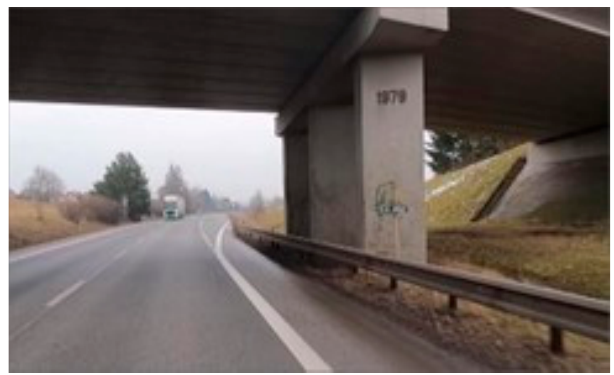
Figure 3. Insufficient minimum distance behind the crash barrier.